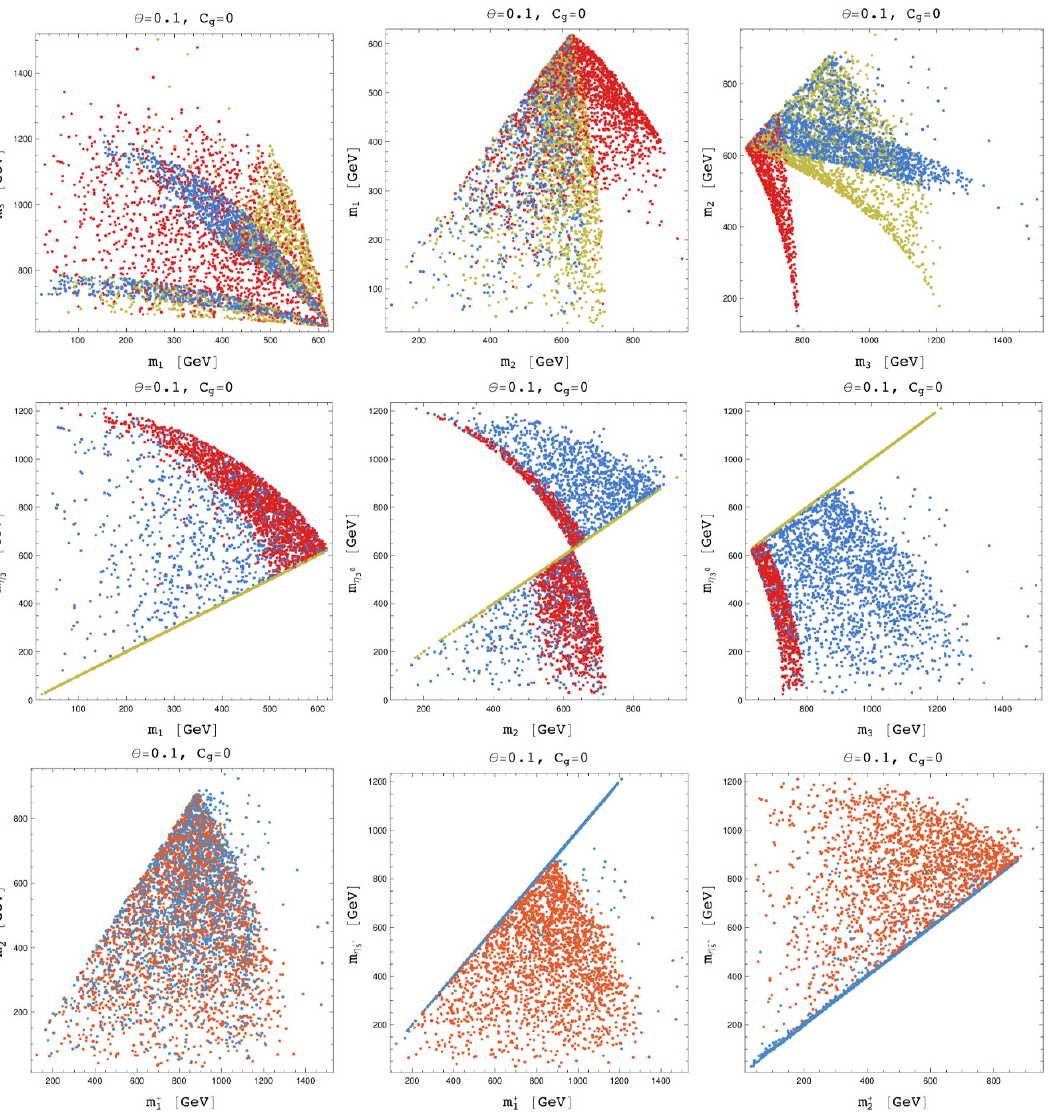
Figure 9 . Correlations among the pNGB masses. The colours represent the dominant fraction of gauge eigenstate in the state quoted on the horizontal axis: for the neutral pseudo-scalars ((cid:12)rst two rows) red stands for the singlet (cid:17) , yellow for (cid:17) 0 and blue for (cid:17) 0 ; for the charged (last row) blue for 1 5 the triplet (cid:17) (cid:6) and orange for (cid:17) (cid:6) . 3 5